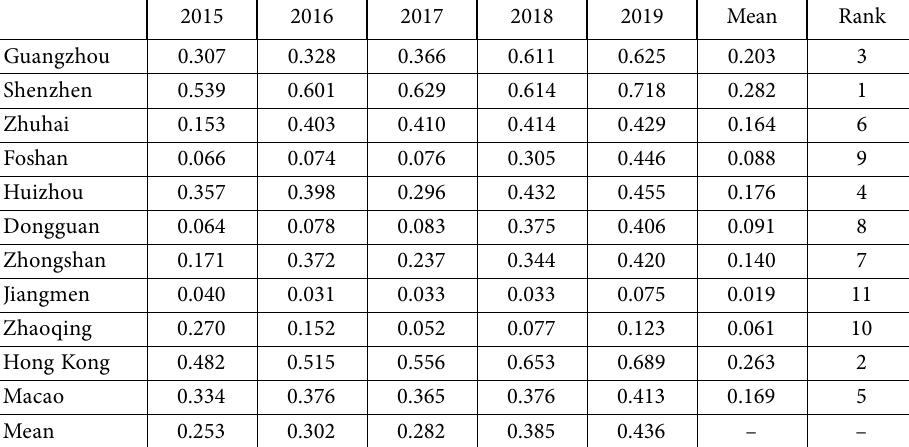
Table 2. Evaluation results of the GBA’s green development